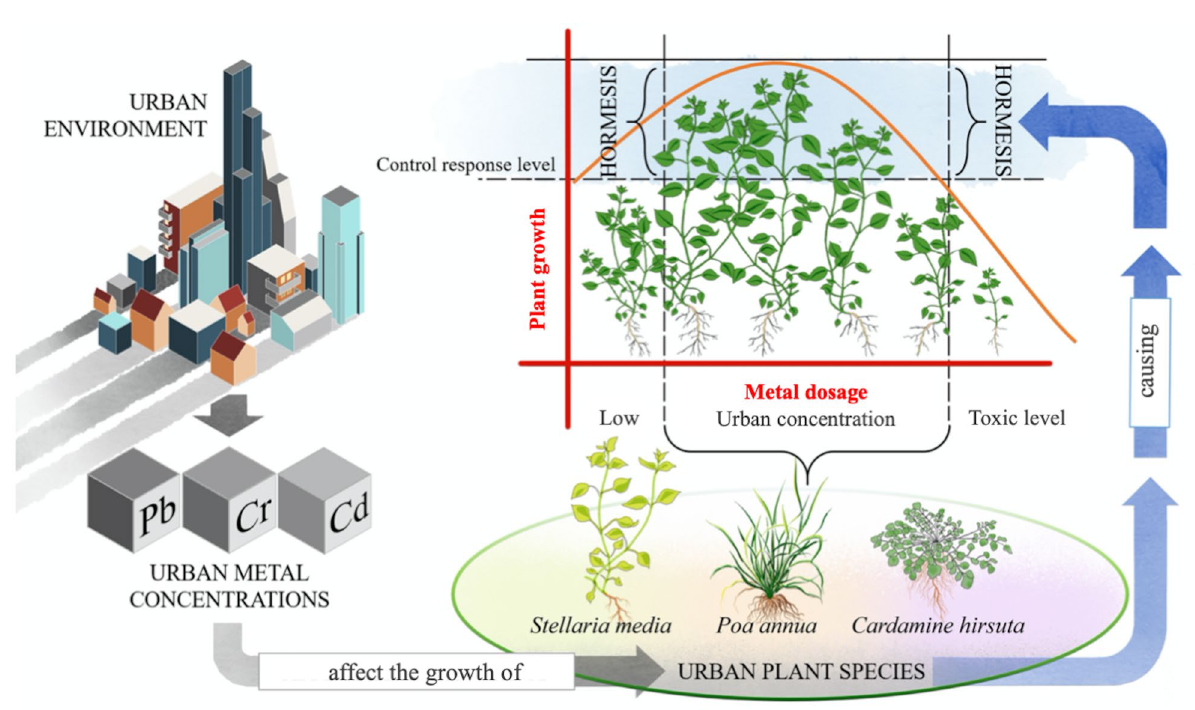
Figure 6. Proposed hormesis effect caused by urban metals on plant growth. Drawings by G.